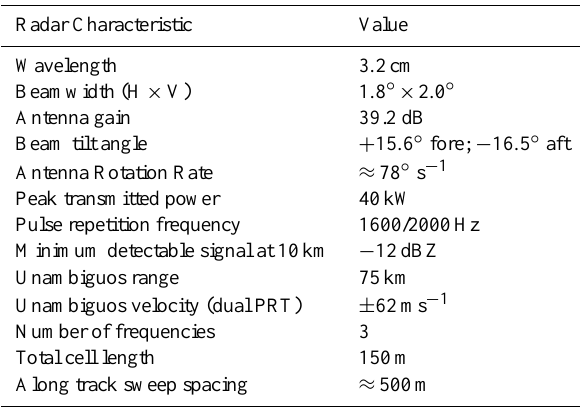
Table 1. Configuration of the ELDORA radar during TPAR- TCS08.